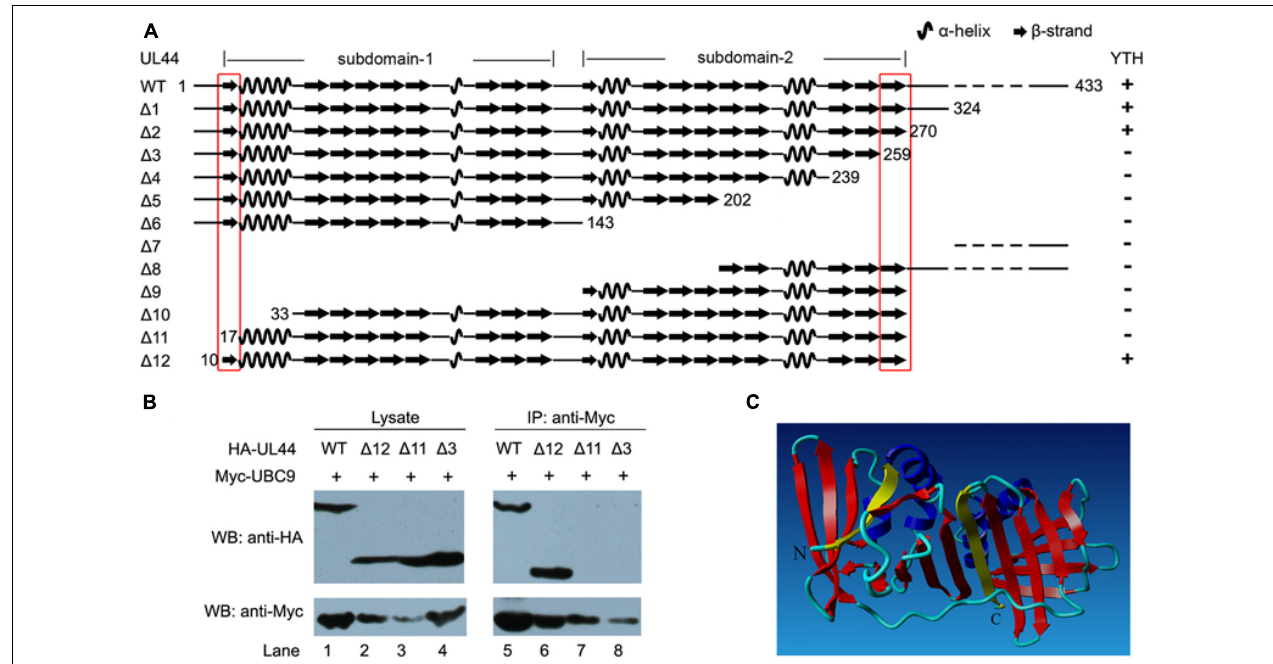
FIGURE 2 | Mapping of the potential UBC9-interacting domains in UL44. (A) Schematic view and structural features of UL44 deletion mutants and their interaction with UBC9 as detected by yeast two-hybrid and β -galactosidase assays. +, positive interaction; –, no interaction. The first and last β -strands are indicated by red box. (B) Effect of different mutation on the interaction of UL44 with UBC9. 293T cells were cotransfected with Myc-tagged UBC9 and HA-tagged UL44 (full length or deletion mutants as indicated), then lysates were incubated with immobilized anti-Myc beads to isolate UBC9 and its associated proteins. (C) Stereoscopic